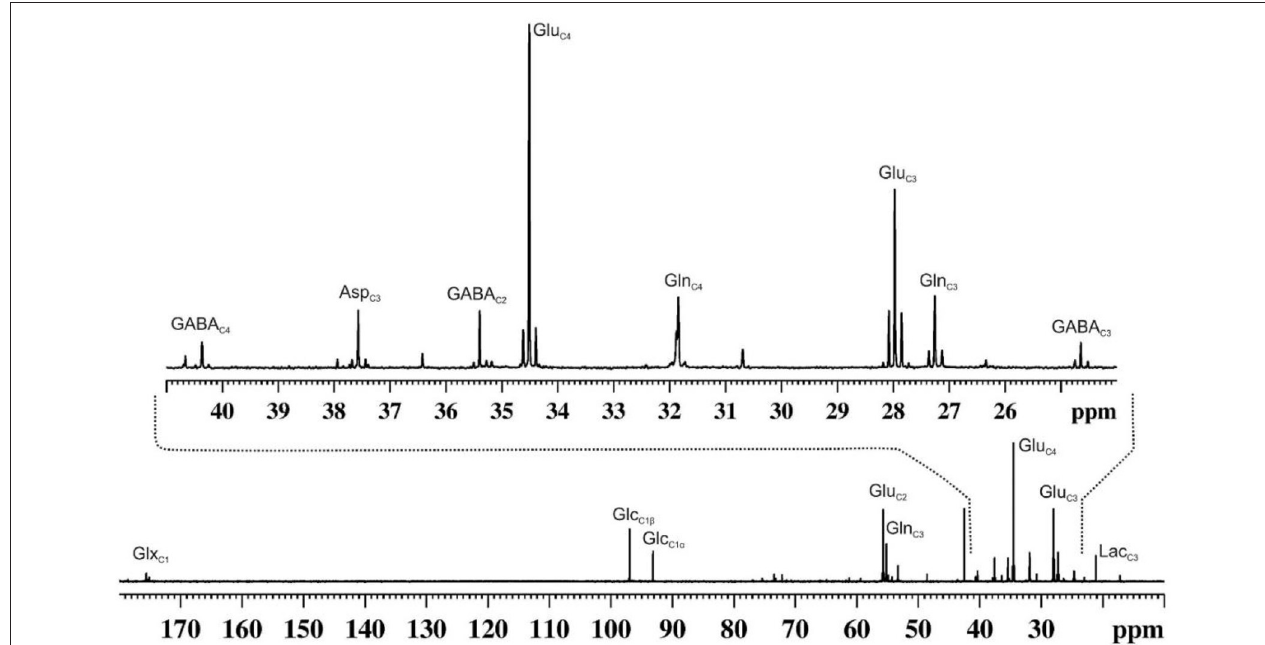
FIGURE 4 | A representative 13 C NMR spectrum of cortical extract of mouse brain showing labeling of various amino acids from [1,6- 13 C 2 ]glucose. Urethane anesthetized mouse was infused with [1,6- 13 C 2 ]glucose for 90min. Brain metabolites were extracted from the cerebral cortex, and 13 C NMR spectrum of the extract was recorded at 150 MHz NMR spectrometer using power gate decoupling. The spectrum shown in the upper panel is the expansion from 24 to 41 ppm. Asp C3 , aspartate-C3; GABA C2 , γ -aminobutyric acid-C2; GABA C3 , γ -aminobutyric acid-C3; GABA C4 , γ -aminobutyric acid-C4; Glu C2 , glutamate-C2; Glu C3 , glutamate-C3; Glu C4 , glutamate-C4; Gln C2 , glutamine-C2; Gln C3 , glutamine-C3; Gln C4 , glutamine-C4; Glx C1 , (glutamate + glutamine)-C1; Glc C1 β , β -D-glucose-C1; Glc C1 α , α -D-glucose-C; Lac C3 ,